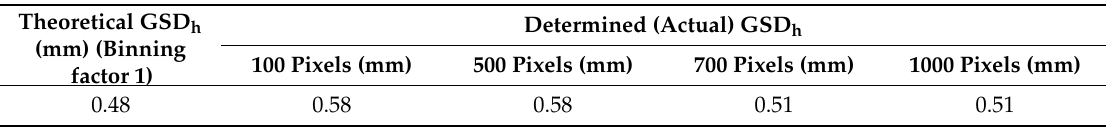
Table 3. Theoretical and actual (determined) spatial resolution along line sensor (GSD v ) for the spectral line at 100, 500, 700 and 1000